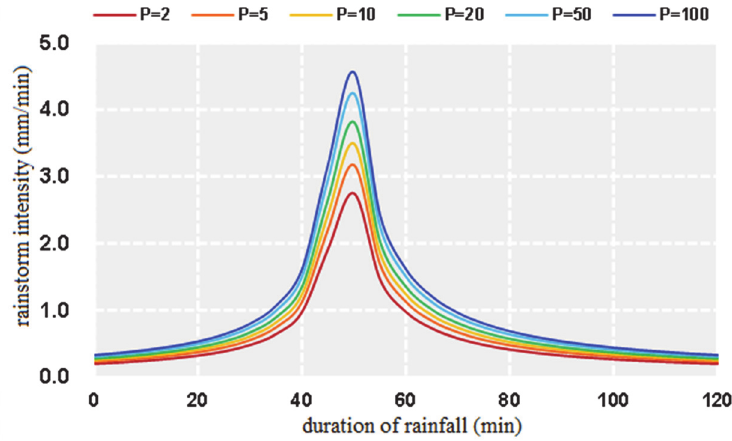
Figure 3. Design rainfall hydrograph.